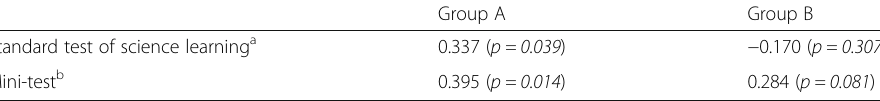
Table 2 Correlation coefficients in the first